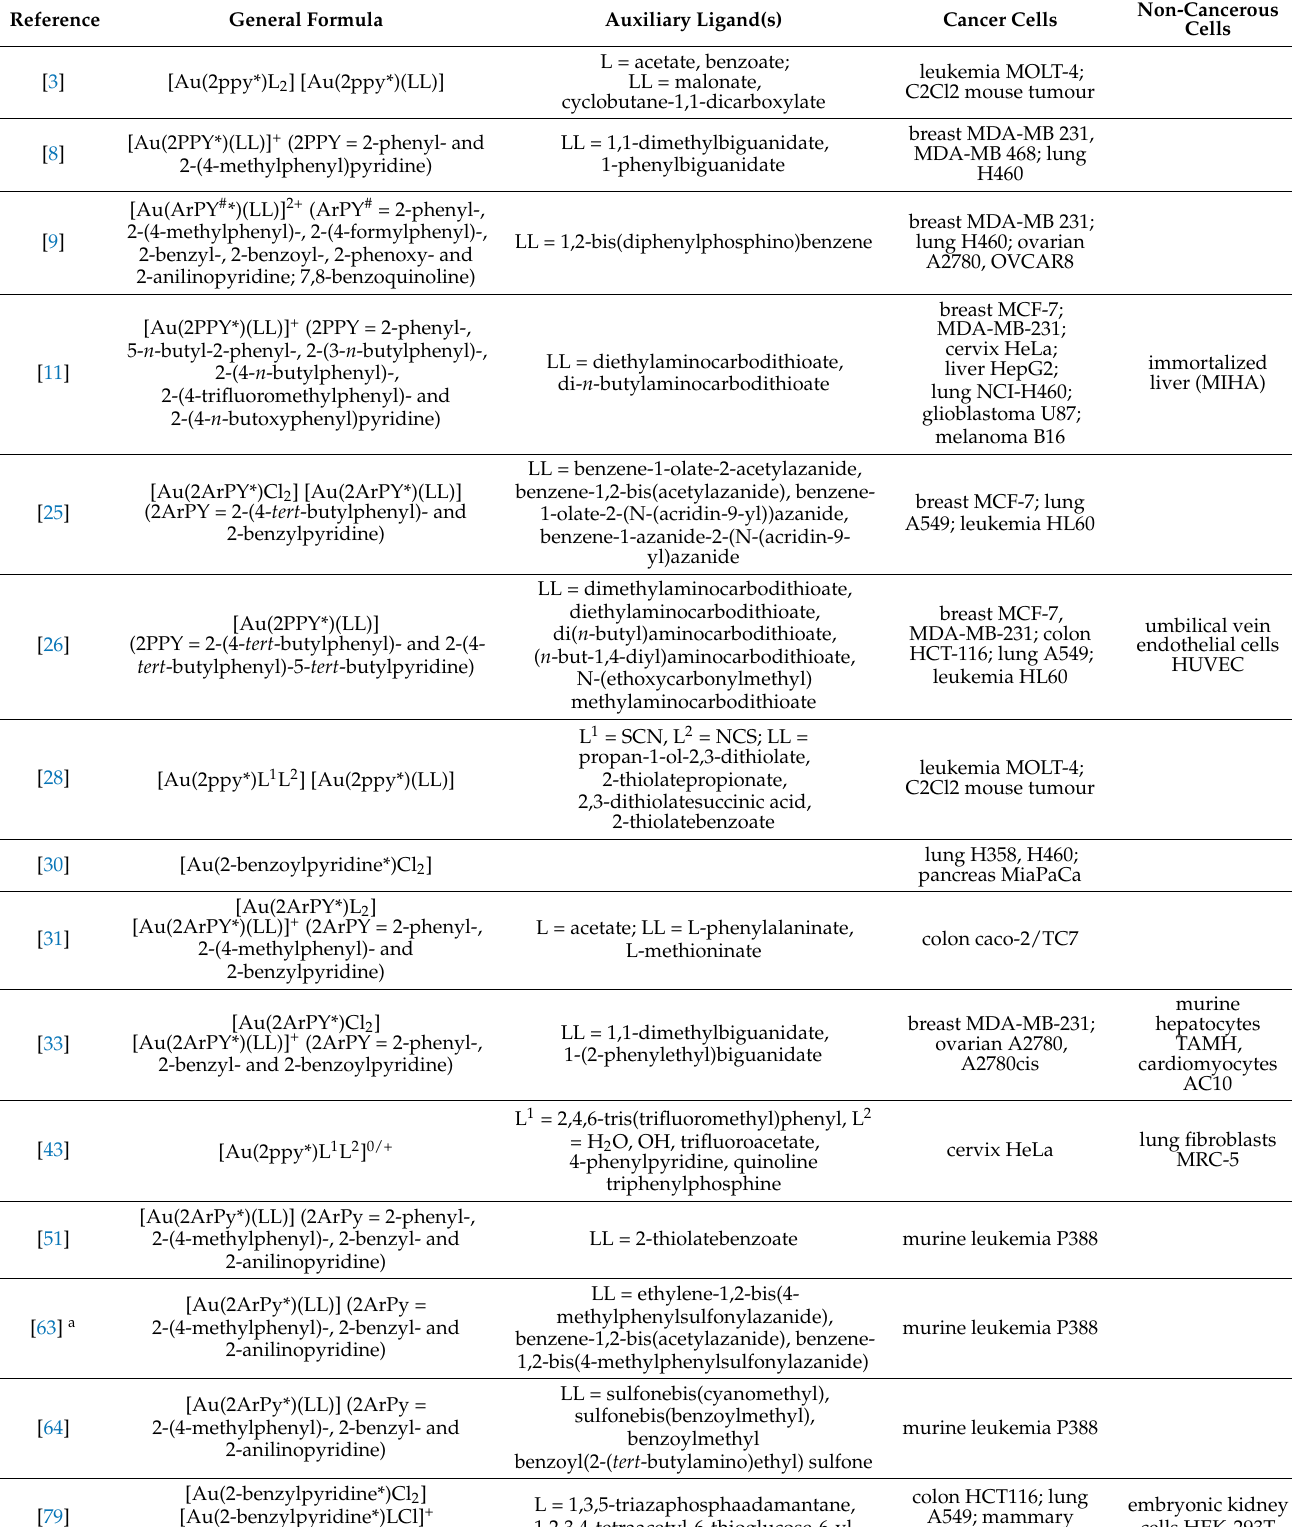
Table 10. Summary of biological activity studies for the reviewed Au(III)